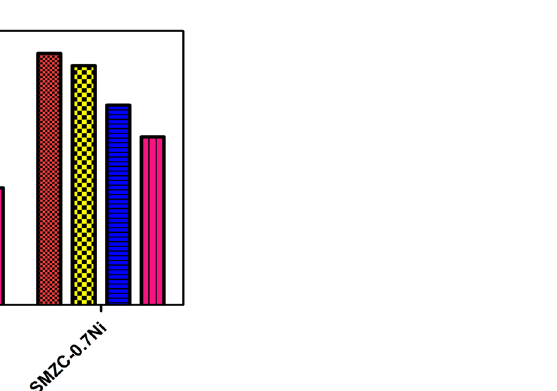
Figure 12. Quantified produced intercellular protein of targeted microbes ( a ) E. coli , ( b ) S. aureus , ( c ) C. albicans , ( d ) A. niger after exposure by the effective dose of four investigated nanocomposites.